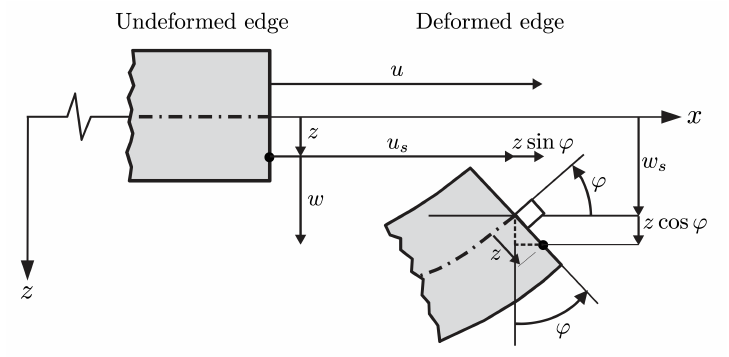
Figure 1. Kinematics of deformation of the presented nonlinear beam